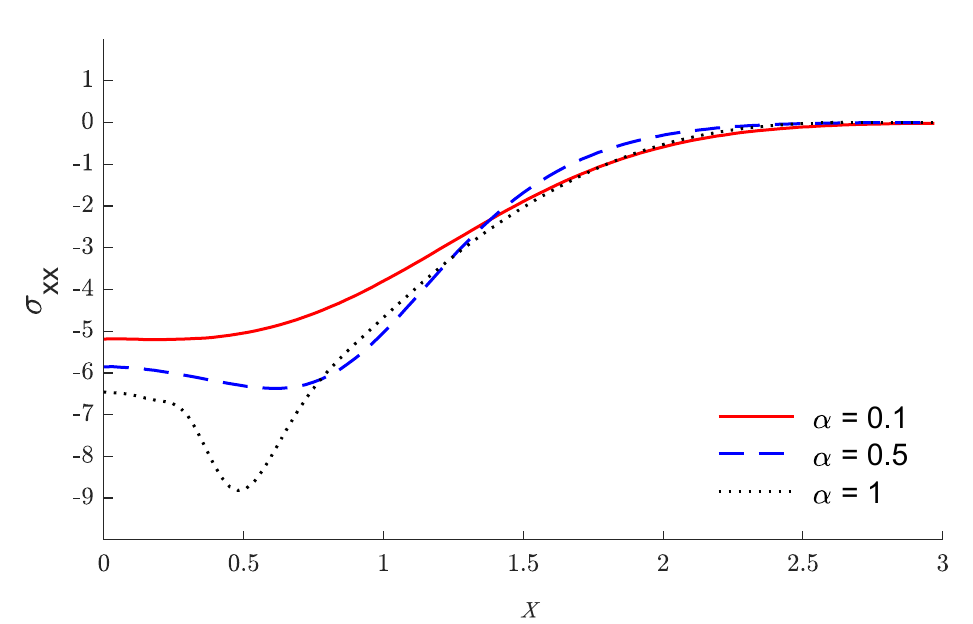
Figure 5. The stress distribution via the distance x for three values of fractional parameters. When τ o = 0.05: